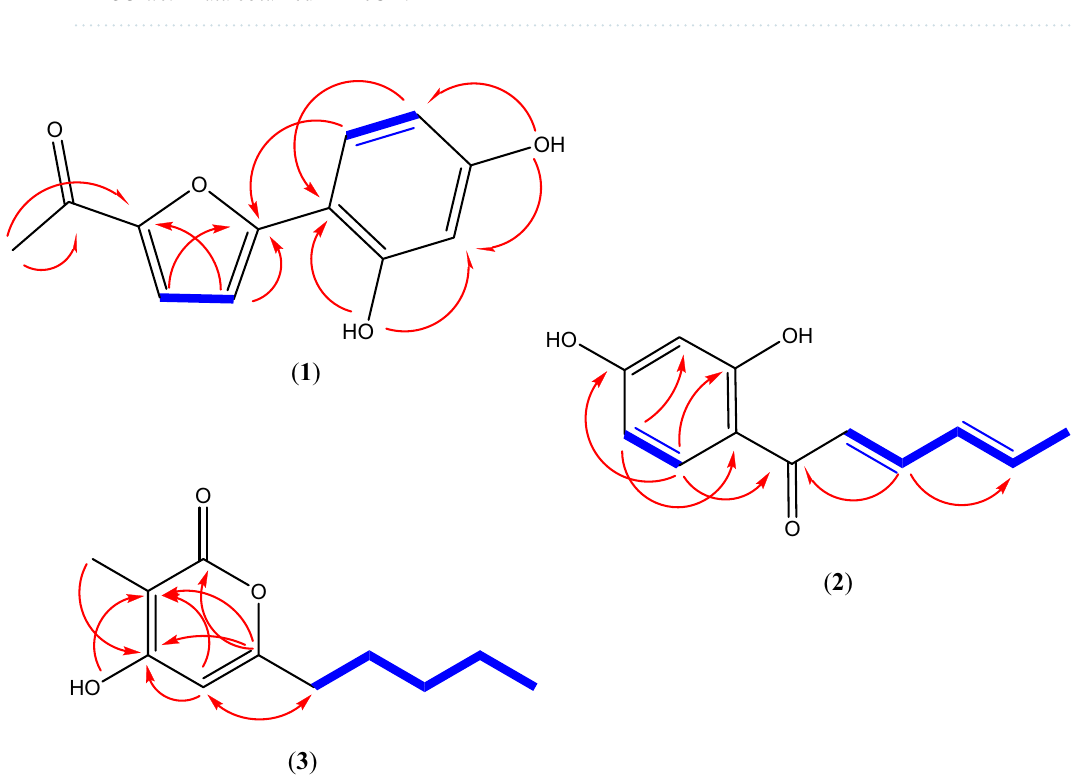
Figure 5. Key HMBC (H → C) and 1 H- 1 H COSY (bold lines) correlations of compounds 1 −